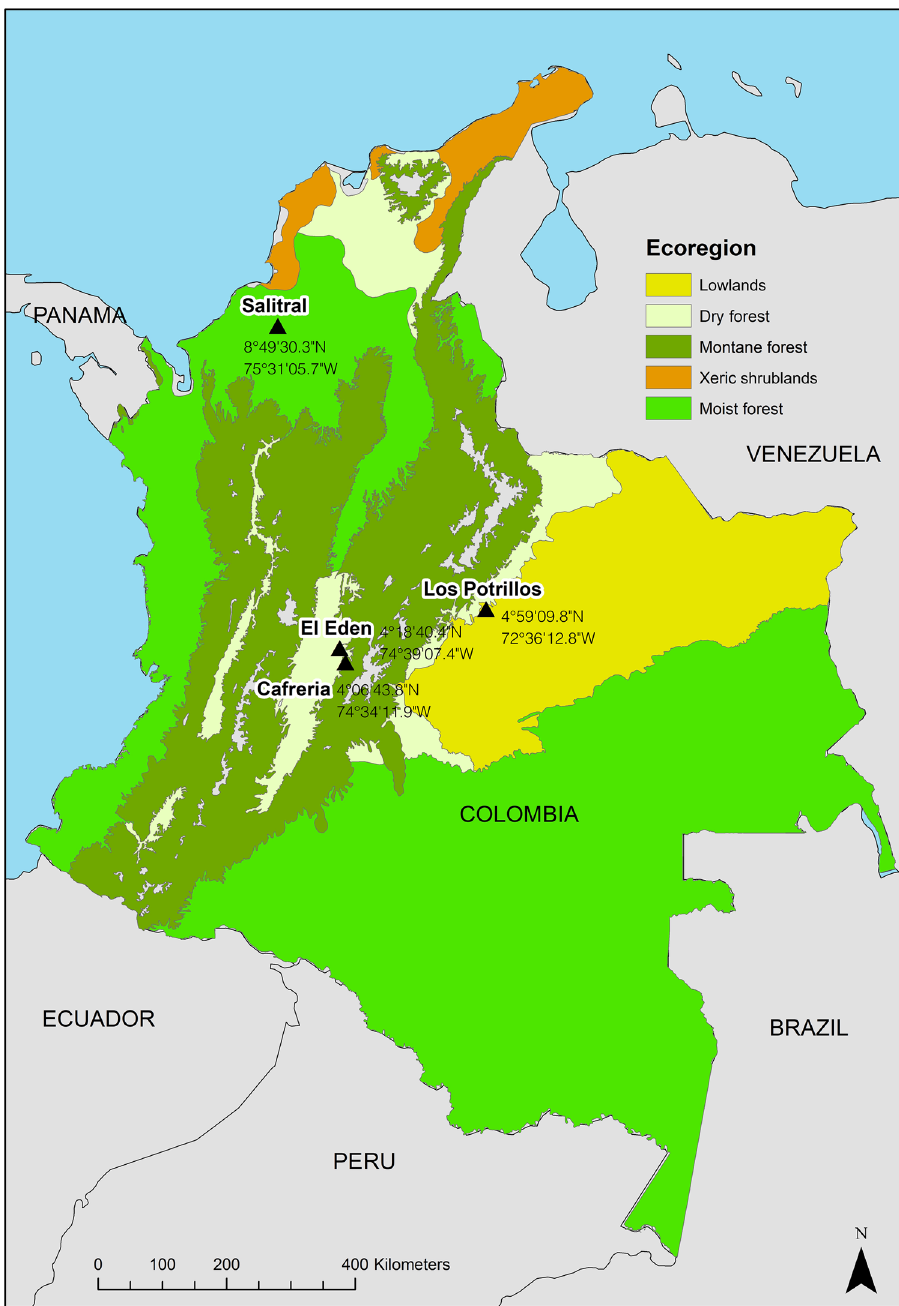
Figure 2. ( A – E ) Heat maps and hierarchical clustering (Bray–Curtis) of each ecoregion based on the scores calculated for each co-occurrence event. The color key for the heatmap is shown in the left superior corner, indicating the range of score values. The heatmaps were performed for each ecoregion, and distribution records for sand flies and mammals are shown ( A ) Dry forest, ( B ) Moist forest, ( C ) Montane forest, ( D ) Lowlands, ( E ) Xeric shrublands. Ecoregions in Colombia and study site. This study considered five ecoregions in Colombia for computing sand fly and mammal species co-occurrences: Lowlands, Dry forest, Montane forest, Xeric shrubs and Moist Forest. In 4 out of the 5 ecoregions, fieldwork was conducted to capture sand fly and mammal species: (1) Los Potrillos, Tauramena municipality, department of Casanare, is the collection site selected in the Lowlands ecoregion. (2) Salitral, the Moist Forest collection site, is located in the Municipality of Sahagun in the Cordoba department. (3) Cafreria located in the Icononzo municipality, department of Tolima, was selected within the Dry forest ecoregion. (4) El Eden, Nilo municipality, Cundinamarca department is found in the Montane forest. Field sites coordinates are shown in the